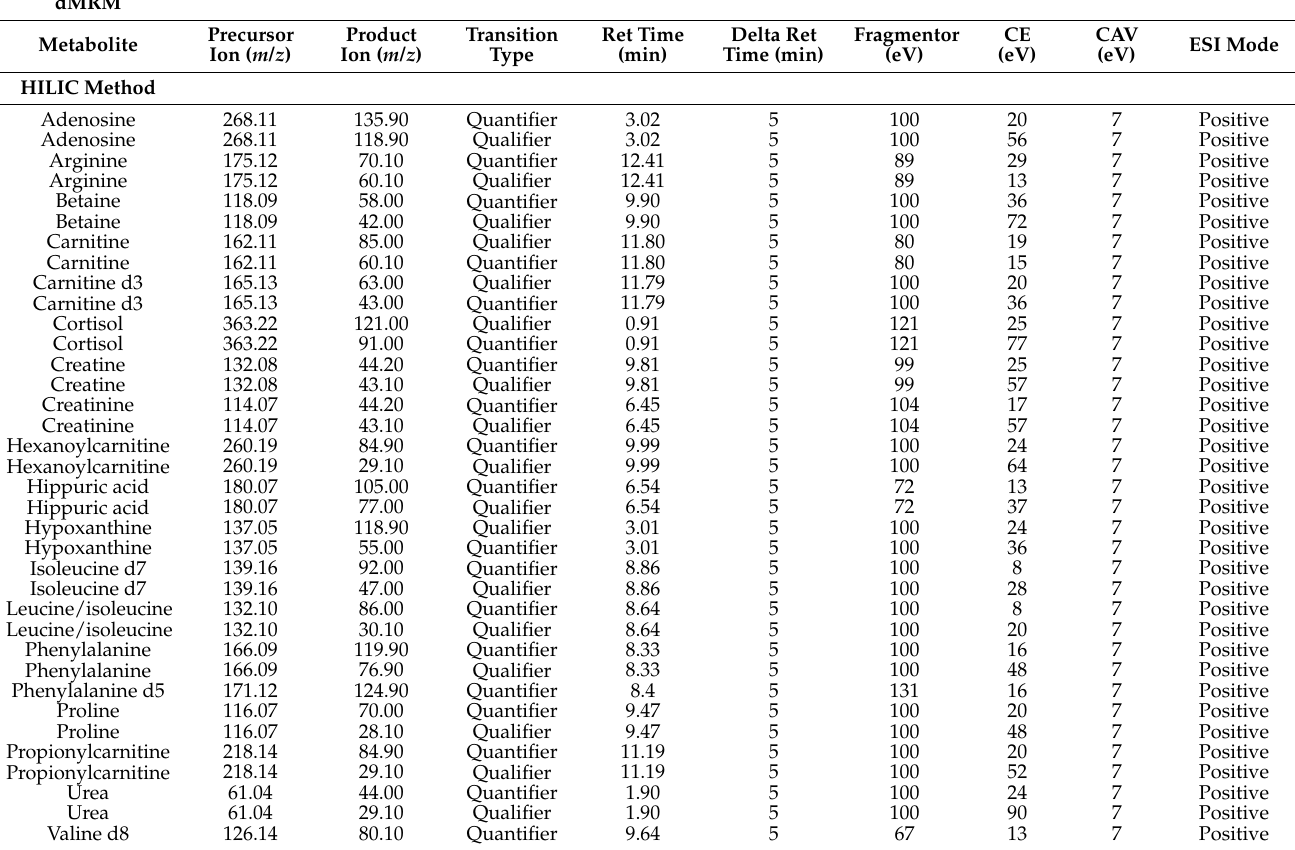
Table 1. Optimized metabolite parameters for HILIC and reversed-phase methods.